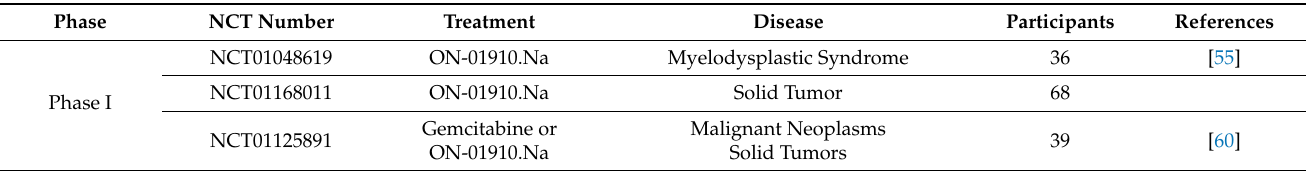
Table 1. Summary of rigosertib clinical